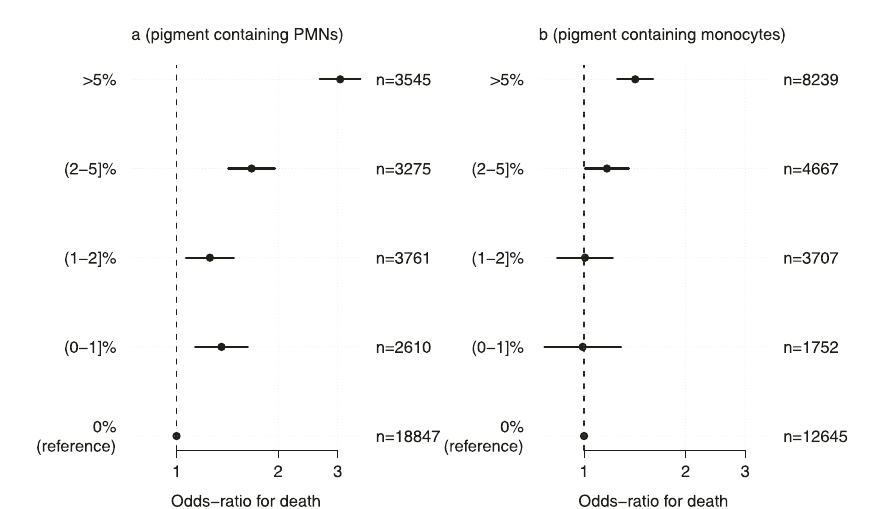
Fig. 3 | Meta-analysis of the prognostic value of pigment-containing PMNs (polymorphonuclearleukocytes. panel a )andmonocytes(panel b )strati fi edinto fi ve levelswith no pigment containing cells asthe reference. Point estimates( fi lled